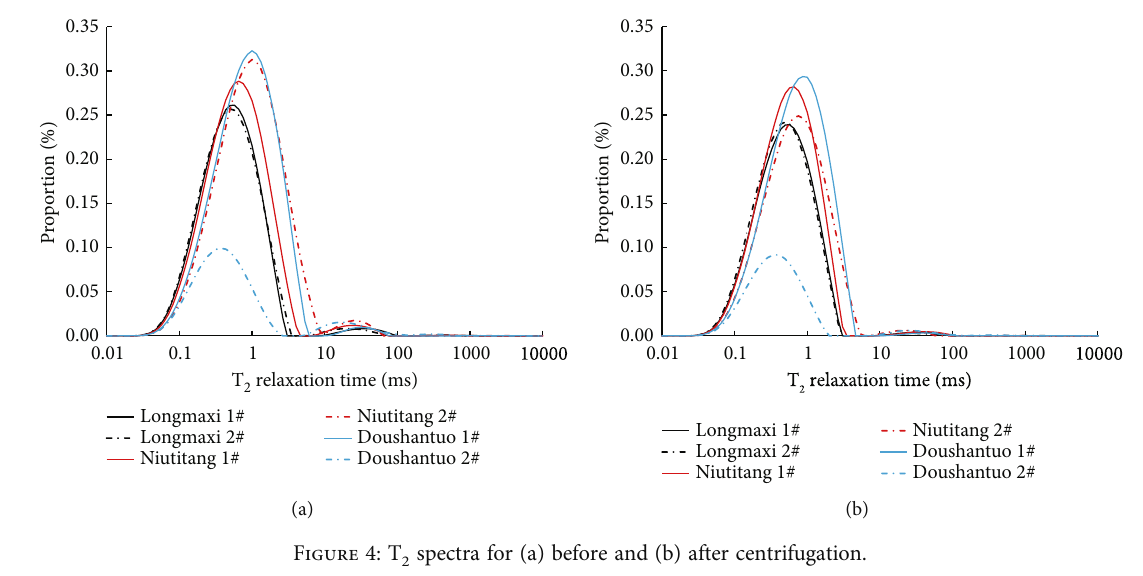
Figure 4: T spectra for (a) before and (b) after centrifugation. 2